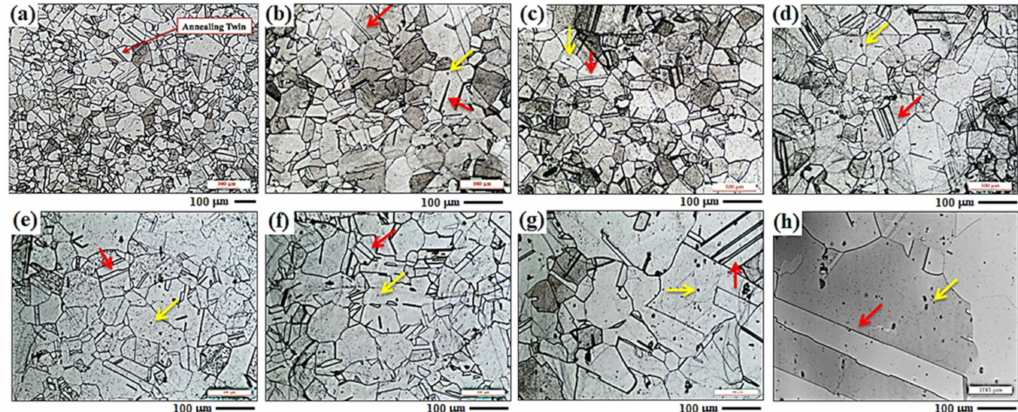
Figure 1. Optical images of Fe-40Ni-24Cr ( a ) As-received and heat-treated samples at different temperatures: ( b ) 950 ◦ C, ( c ) 1000 ◦ C, ( d ) 1050 ◦ C, ( e ) 1100 ◦ C, ( f ) 1150 ◦ C, ( g ) 1200 ◦ C and ( h ) 1250 ◦ C. Note: Annealing twin (red arrows) and precipitates (yellow